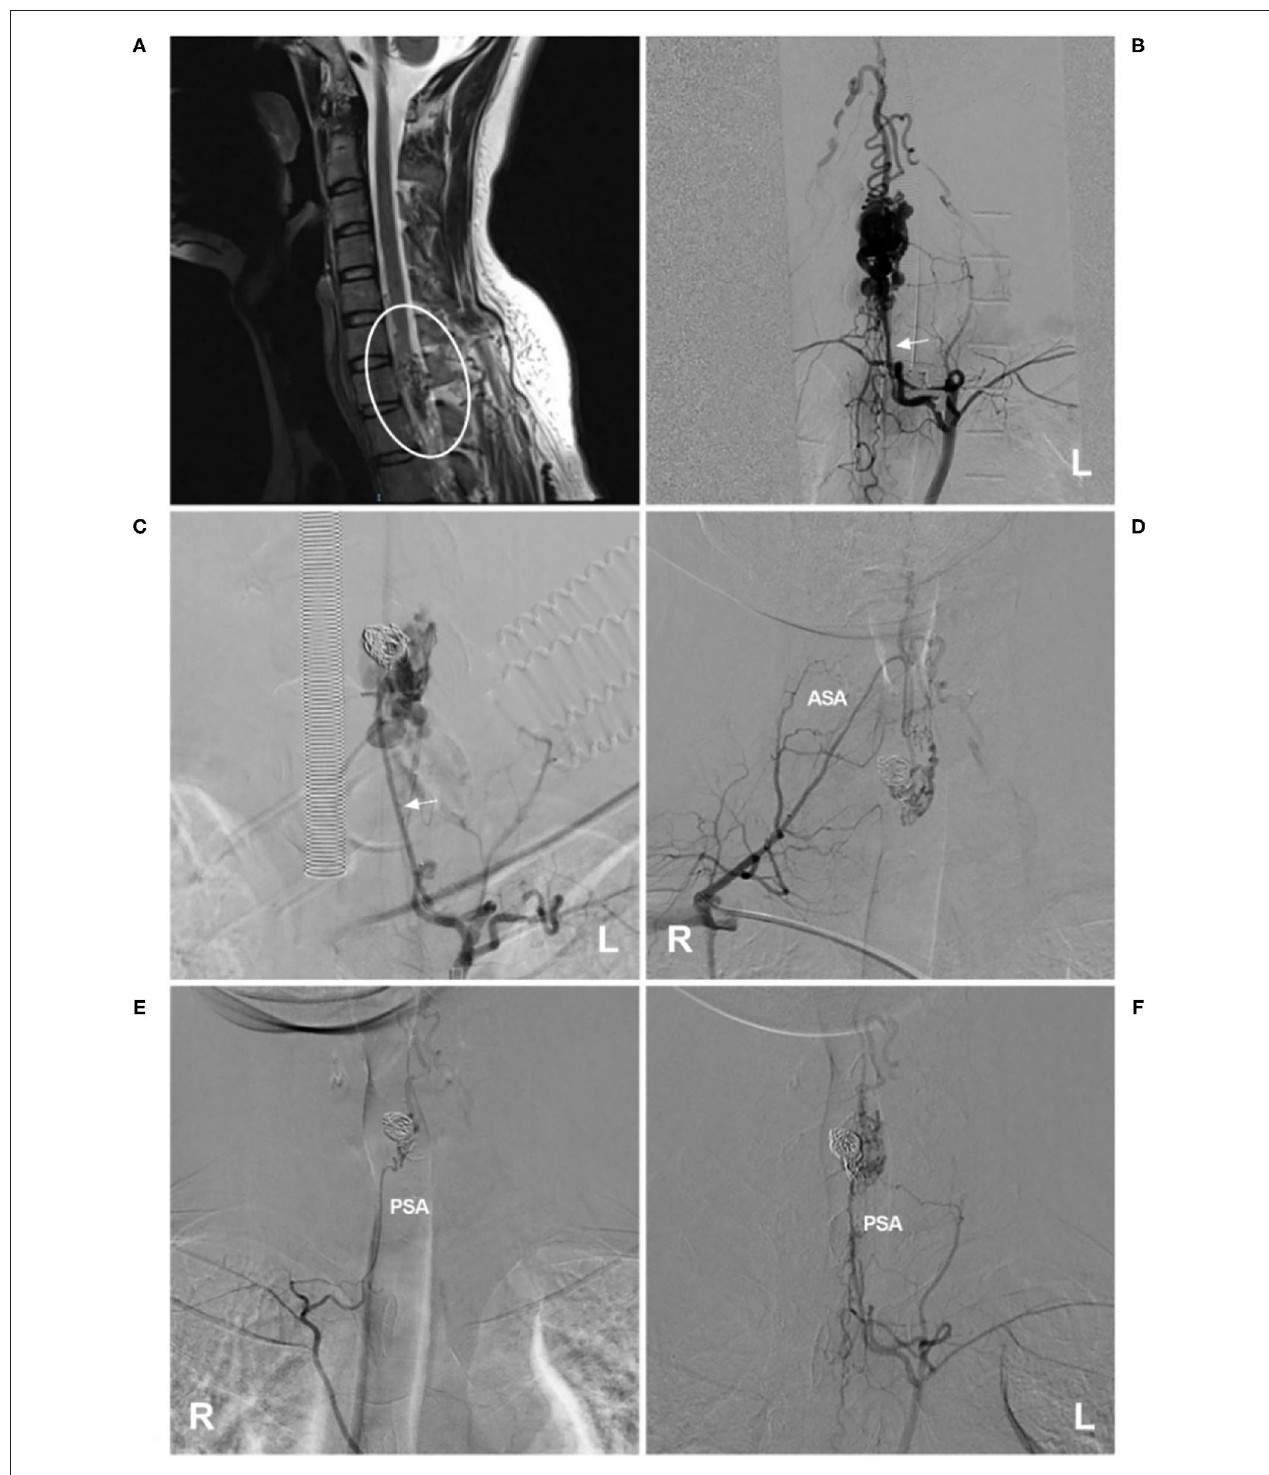
FIGURE 4 | EVT of a cervical intramedullary glomus arteriovenous malformation. (A) MRI showed an intramedullary glomus AVM near the C7 level (circle). (B) Left angiogram of the supreme intercostal artery showed that the AVM was mainly supplied by the dilated radiculomeningeal artery (arrow). (C) The aneurysm in the AVM was coiled first via the radiculomeningeal artery (arrow), and then the NBCA was cast. (D–F) Six-month follow-up angiograms showed that the AVM had decreased. Radiotherapy was recommended. (D) shows an angiogram via the right costocervical trunk revealing that the ASA was involved as the feeder. (E,F) show angiograms via the left and right supreme intercostal arteries, revealing that the PSA was the feeder. AVM, arteriovenous malformation; ASA, anterior spinal artery; EVT, endovascular treatment; L, left; MRI, magnetic resonance imaging; NBCA, N-butyl cyanoacrylate; PSA, posterior spinal artery; R, right.